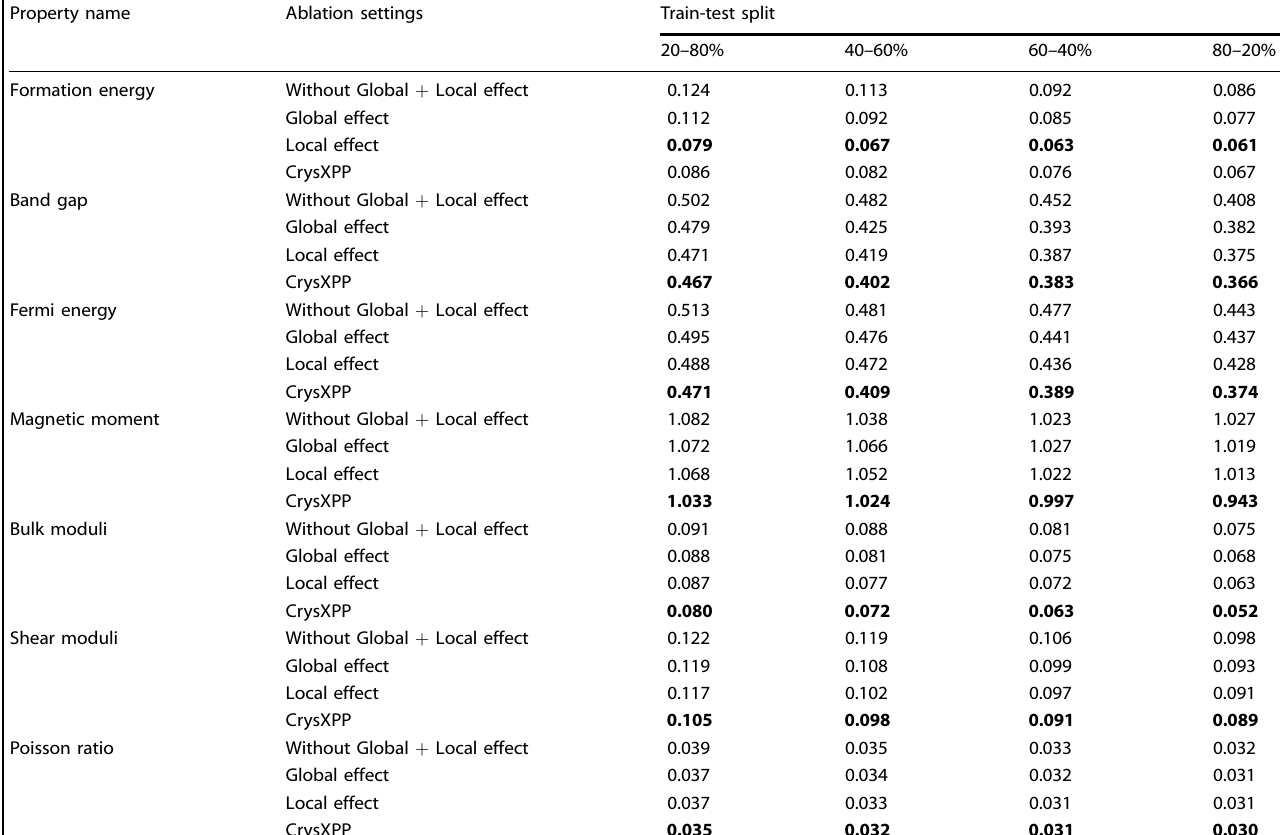
Table 5. Summary of experiments of ablation study on the importance of different reconstruction loss components on CrysAE training and eventually its effect on CrysXPP (MAE for property prediction).